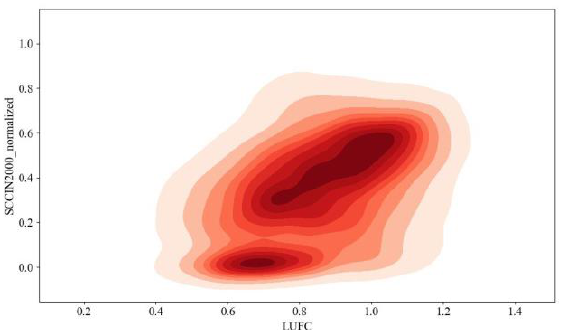
Figure 8. Landscape ecological risk index and functional conflict risk index double probability density map.